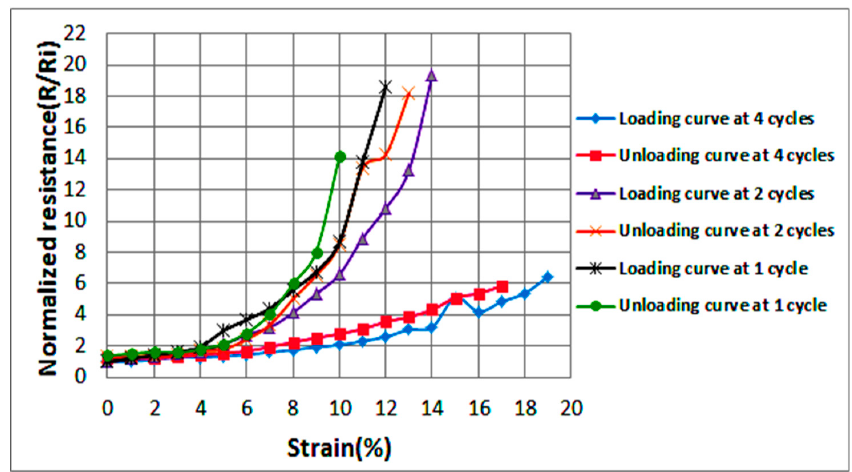
Figure 12. Average normalized resistances of two sinusoidal samples at various cycles as the applied strain increases (loading) and decreases (unloading).